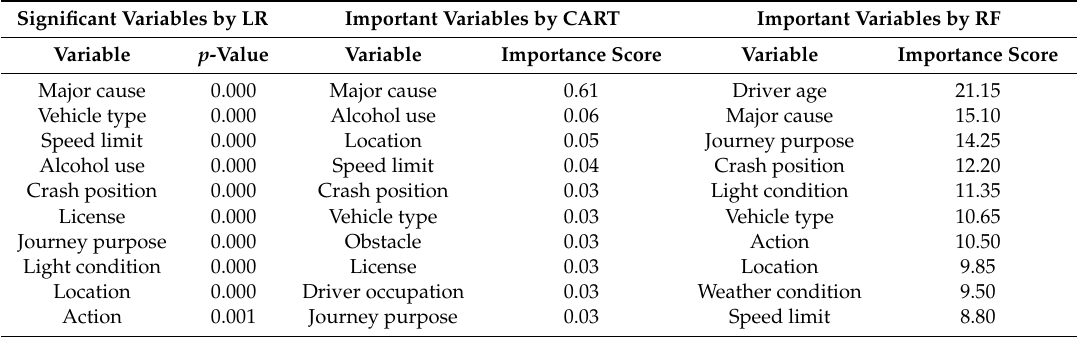
Table 3. Comparisons between significant variables and important variables. LR: logistic regression; CART: classification and regression tree; RF: and random forest.